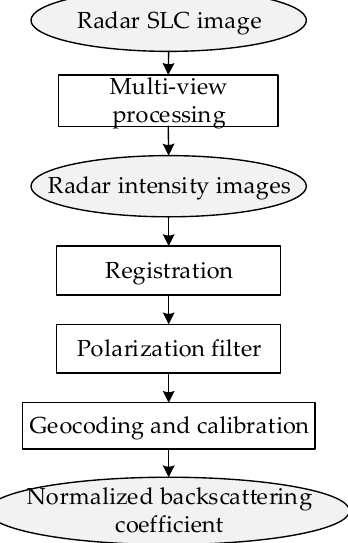
Figure 3. Sentinel-1 SAR data preprocessing process.